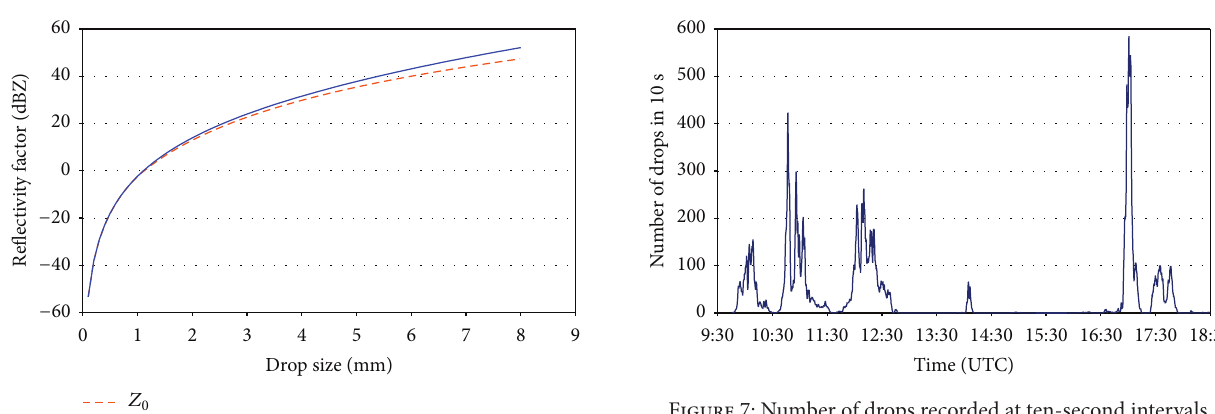
Figure 7: Number of drops recorded at ten-second intervals.